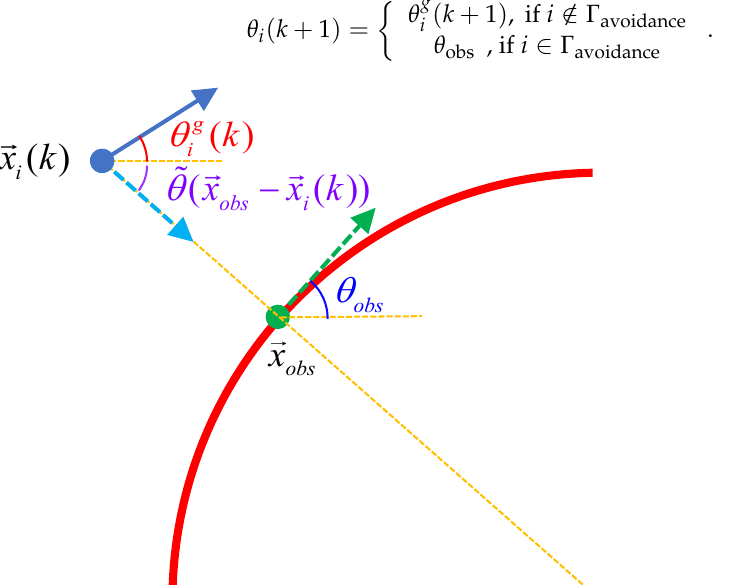
Figure 3. The expression of related variables in the process of the UAV avoiding the obstacle. The red curve represents the obstacle, and the green point represents the nearest obstacle point to the